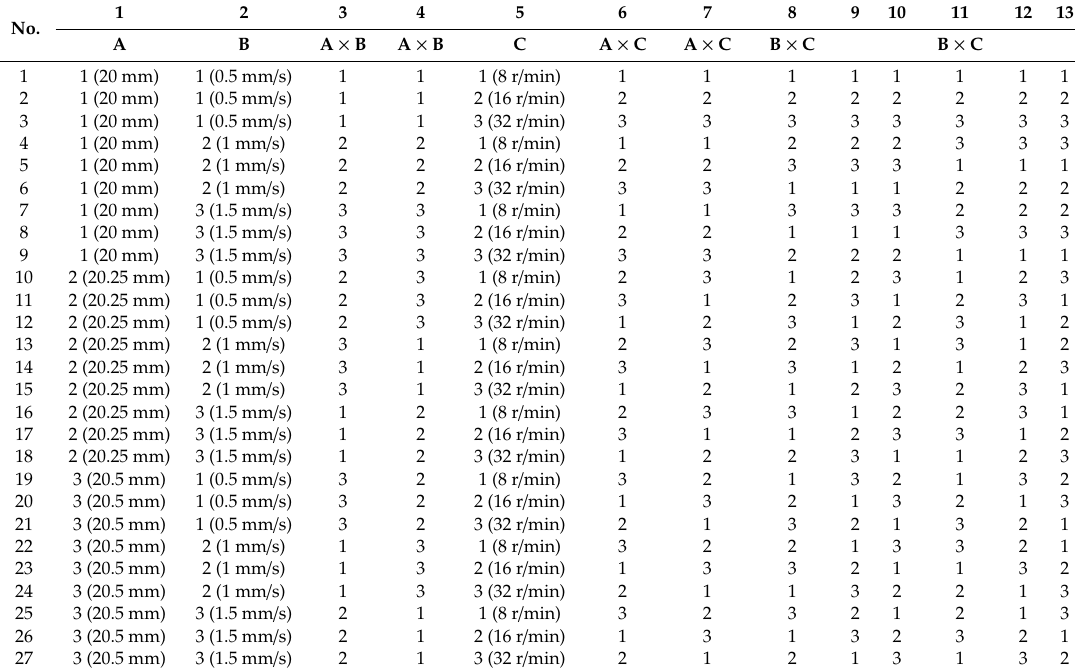
Table 2. Orthogonal experiment design array.